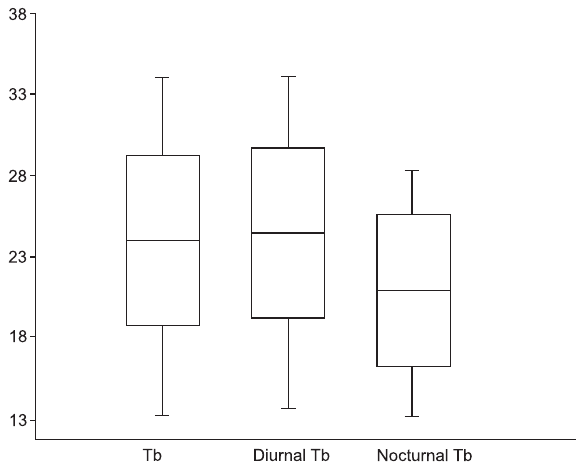
Figure 4. Descriptive statistics (mean and standard deviation) for the body temperatures of Amphisbaena munoai found at São Jerônimo between March 2011 and October 2012. Tb: body temperatures for the entire study (n = 183); diurnal Tb: body temperatures for the diurnal study (n = 163); total nocturnal Tb: body temperatures for the nocturnal study (n = 22).